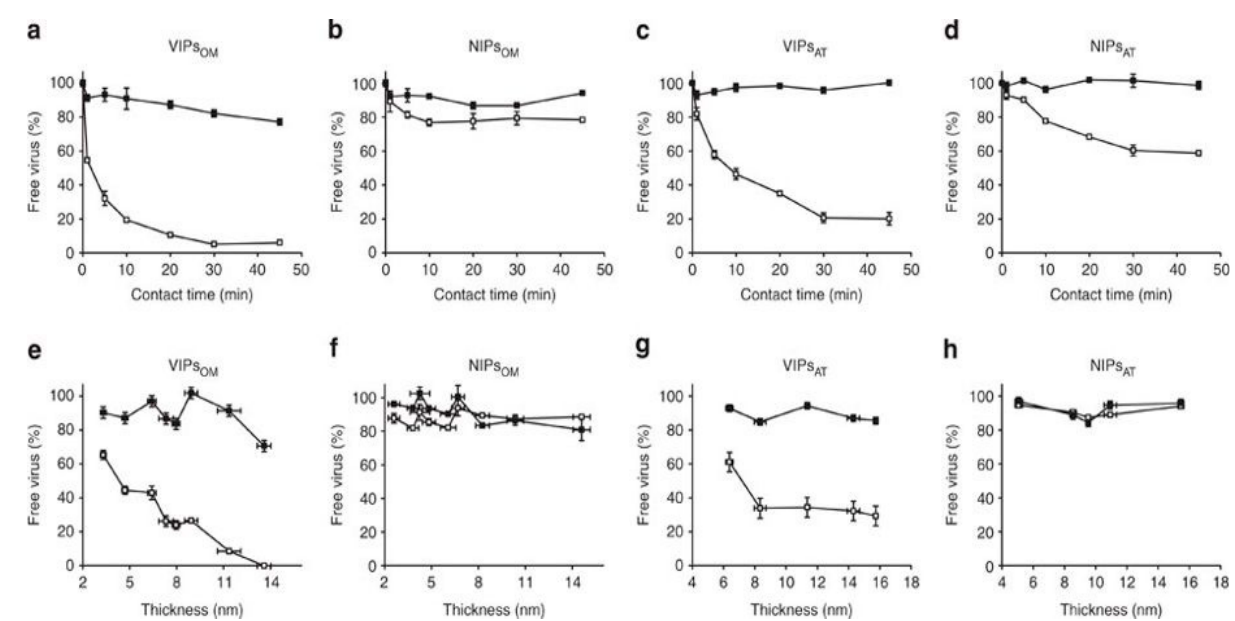
Figure 6. Binding of virions of the templated turnip yellow mosaic virus (TYMV) and non-templated tomato bushy stunt virus (TBSV) to virus imprinted polymers (VIPs) and non-imprinted particles (NIPs). Symbols are for TYMV (open squares) and for TBSV (solid squares). Binding time, selectivity, composition and thickness of the recognition layer were compared. ( a – d ) Four types of particles were assayed: ( a ) VIPs OM , ( b ) NIPs OM , ( c ) VIPs AT , and ( d ) NIPs AT ; OM and AT particles with 8-mm-thick recognition layers. ( e – h ) Nanoparticles with recognition layers of increasing thicknesses (mean ± s.e.m.) were assayed: ( e ) VIPs OM , ( f ) NIPs OM , ( g ) VIPs AT , and ( h ) NIPs AT . All values are presented normalized in percentage of initial virus concentration (mean ± s.e.m.)(The term VIPs OM stands for particles imprinted with TYMV virions and having a recognition layer composed of an organosilanes mixture (OM), and the term non-imprinted particles (NIPs) OM for NIPs produced in the absence of template using the same OM. As controls, we selected two additional formulations, one with tetraethyl orthosilicate (TEOS) alone and one with a mixture of APTES and TEOS (AT). The corresponding VIPs are abbreviated VIPs AT for TYMV imprinted particles having a recognition layer made of AT and NIPs AT for those produced under the same conditions in the absence of template) ((Reproduced with permission from Reference [72]).